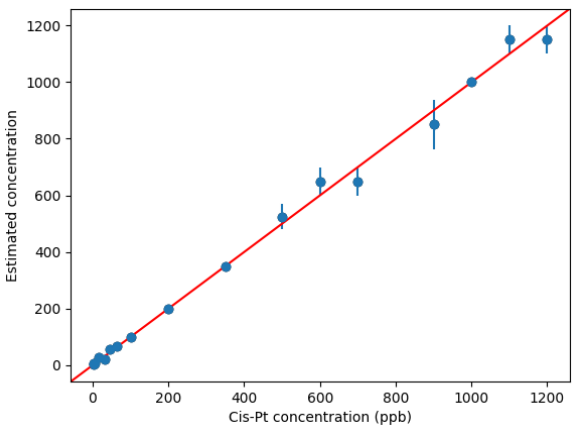
Figure 5. Quantitative measurements by ML: on the y -axis, the values predicted by the ML method are shown against the experimental concentrations of cisplatin (on the x -axis). For each concentration, the average value of the prediction is displayed by using a dot (the bars indicate the corresponding standard deviations). The red line sets the reference for the correct prediction.